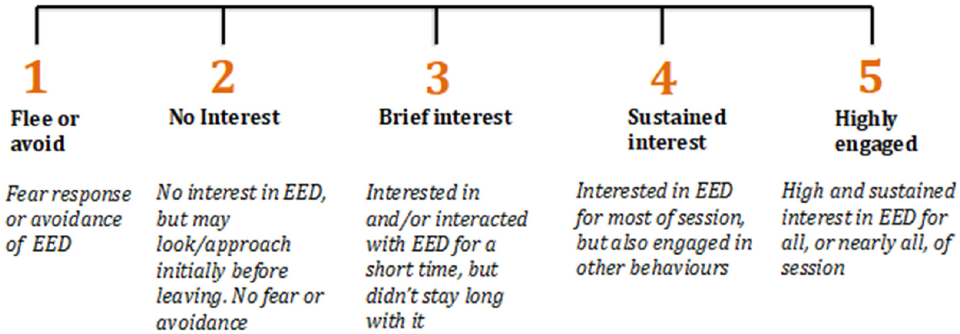
Figure 2. Five-point Likert scale used by caretakers to score each dolphin’s engagement with enrichment items every time enrichment was provided over the 8-week study.